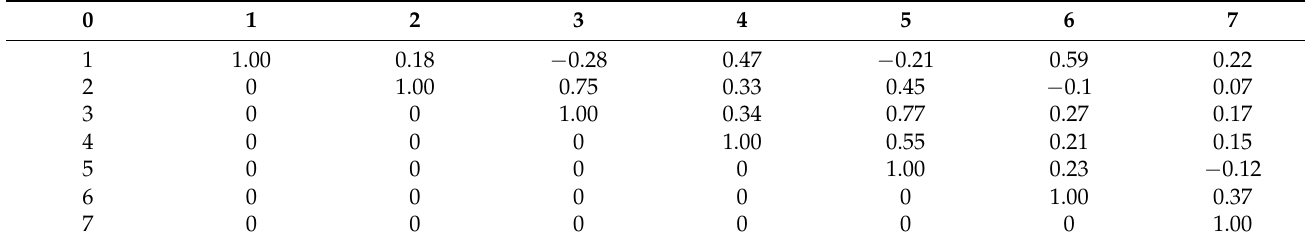
( 2 ) ( i ) ; ν ,i = 1,7 (preceding crop—rapeseed). 1 ν